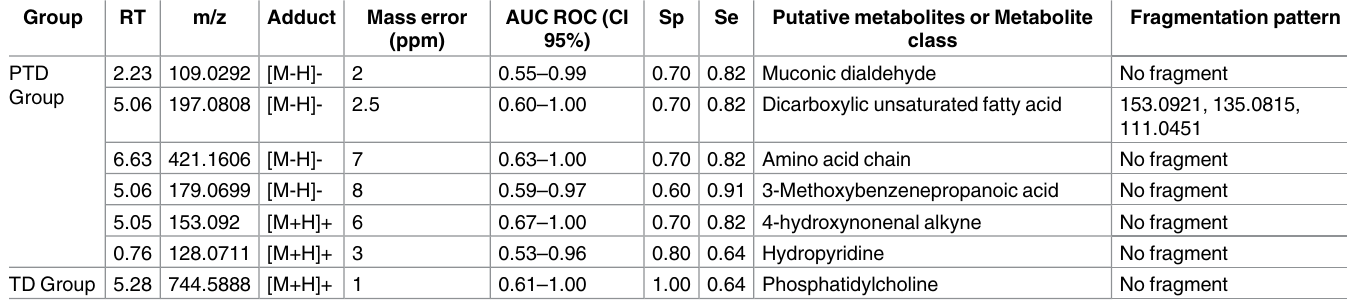
RT = Retention Time; m/z = mass-to-charge ratio; ppm = part per million; AUC = Area under the Curve; ROC = receiver operating characteristics; Sp = specificity; Se = sensitivity; the optimal threshold used for specificity and sensitivity is the point closest to the top-left part of the plot with perfect sensitivity or